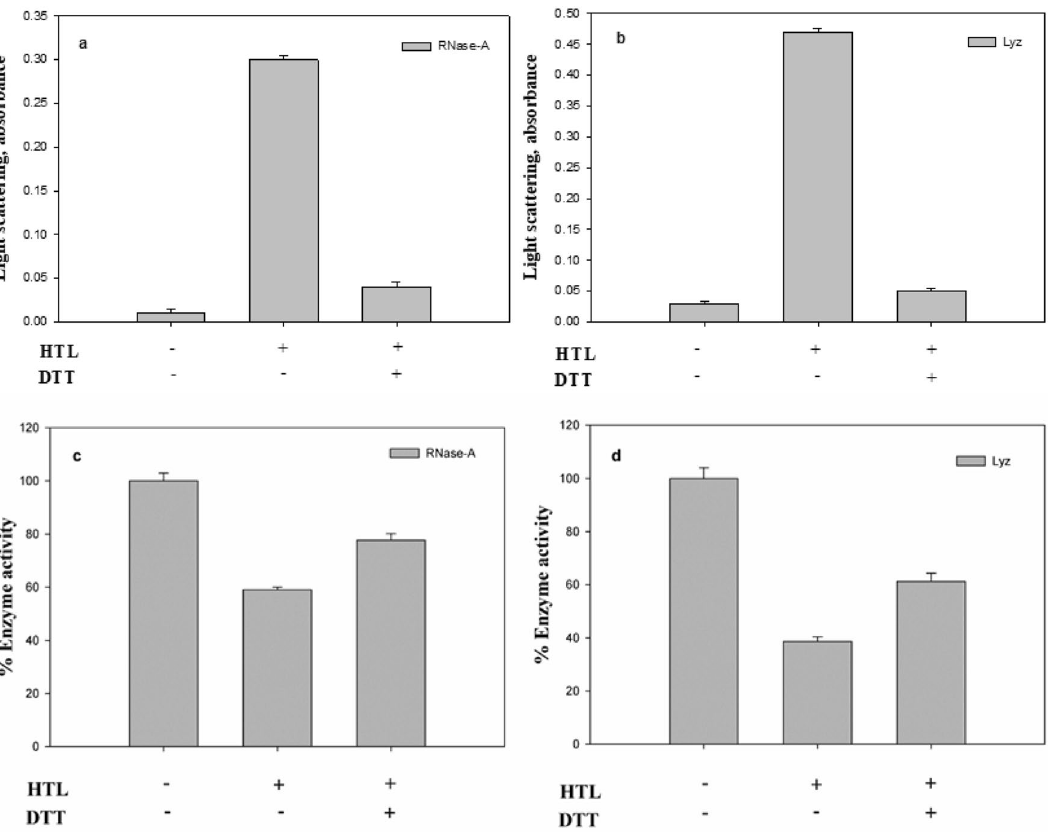
Figure 4. Behavior of HTL-modified proteins in presence of DTT: Light scattering intensity of oligomers formed by HTL-modified RNase-A (panel a ) and Lyz (panel b ) samples of day 6 upon addition of DTT. Enzyme activity of oligomers formed by HTL-modified RNase-A (panel c ) and Lyz (panel d ) samples of day 6 upon addition of DTT.